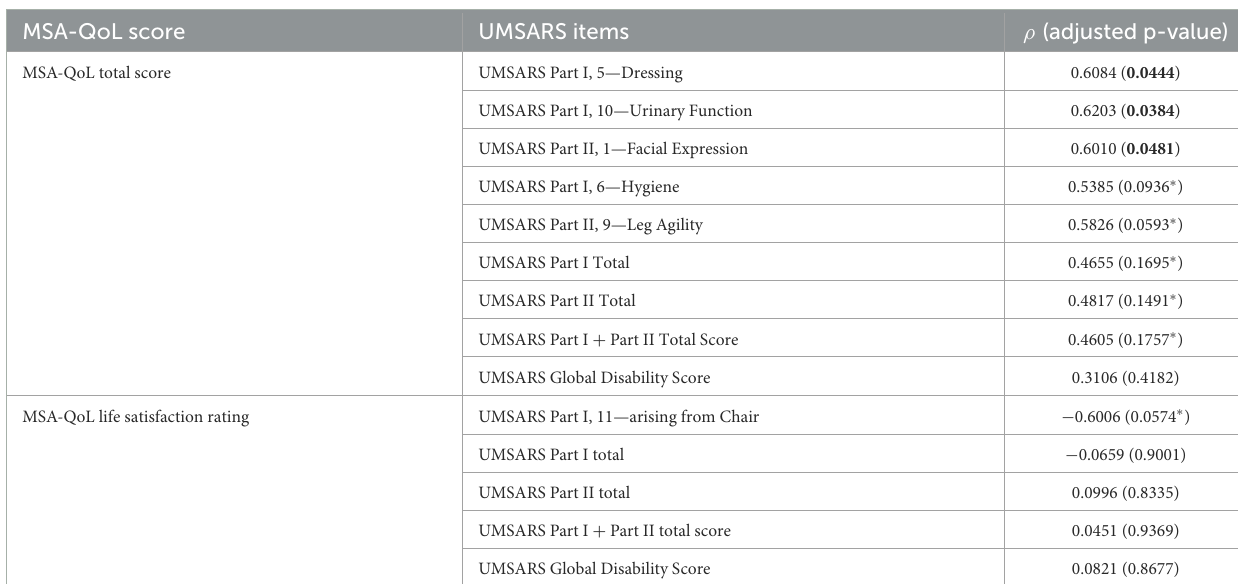
TABLE 4 Correlations of MSA-QoL scores with UMSARS items.